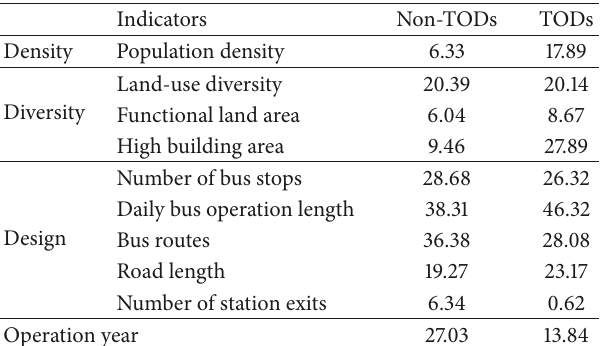
Table 6: Difference between the average projected and real values of inefficient stations